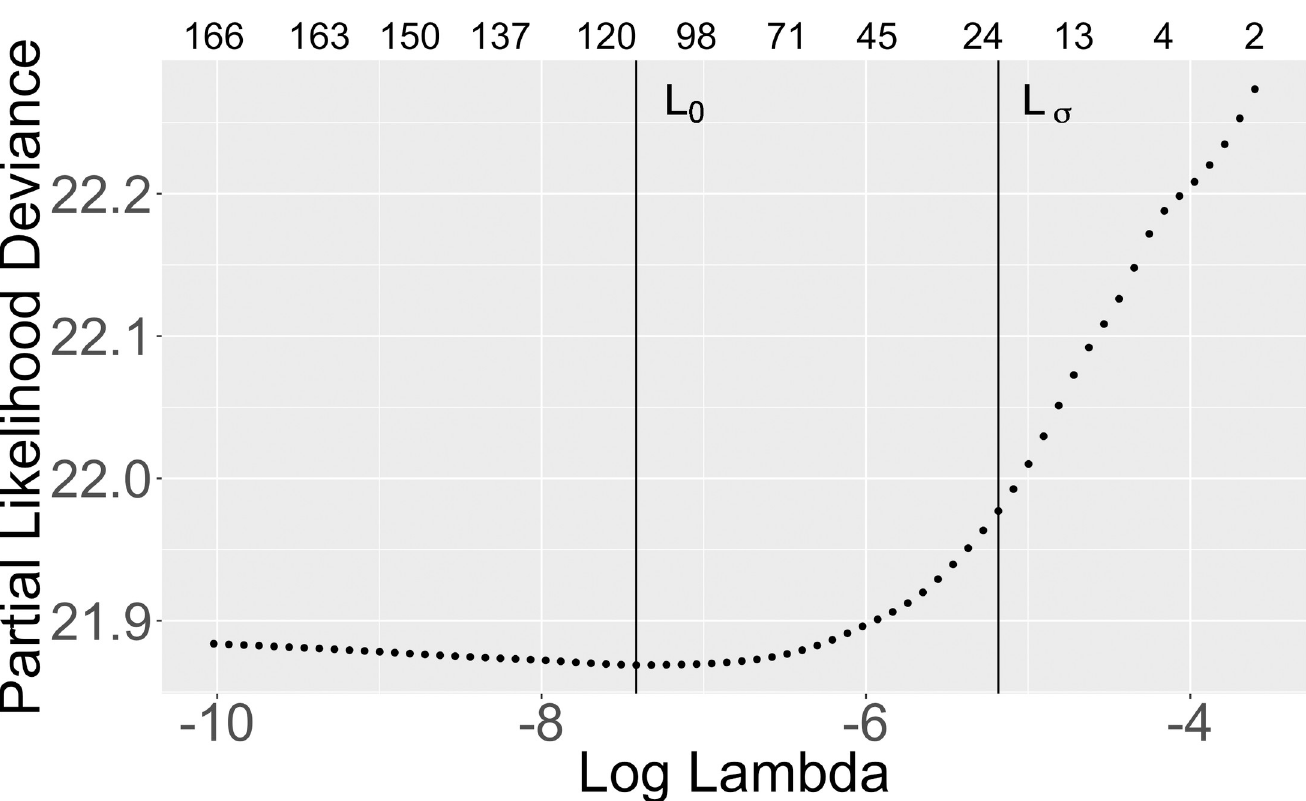
Fig 4. Cox lasso variable selection for recipients ages 50 and under. The top row represents the number of non-zero coefficients per Lasso penalty value, lambda. The vertical line L0 corresponds to the optimal penalty, which minimizes the PLD. The line L σ corresponds to the largest penalty value corresponding to the PLD values within one standard deviation of the minimum PLD.